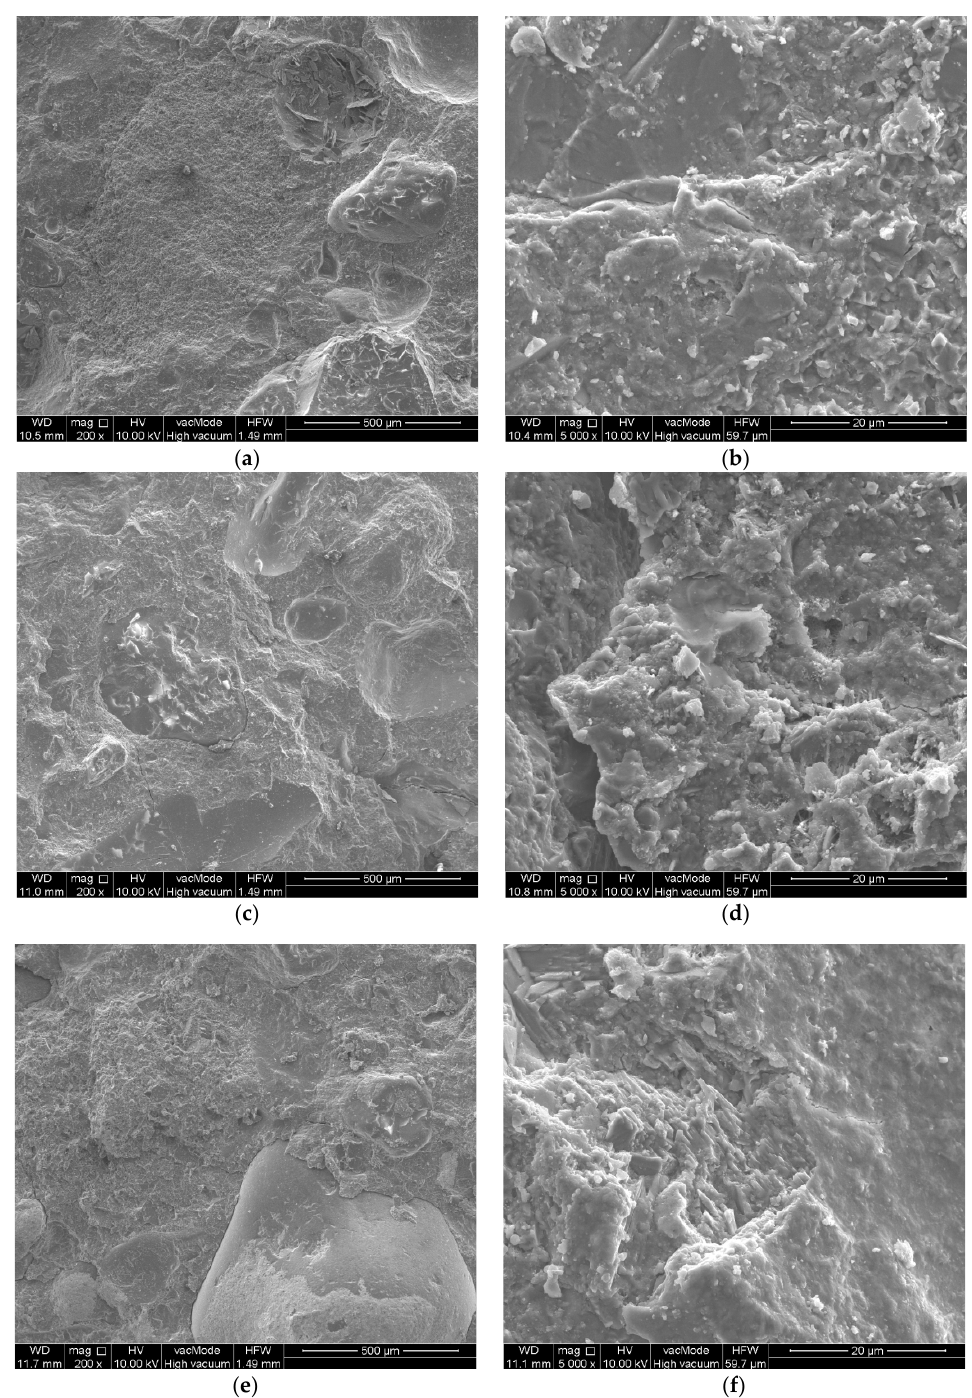
Figure 16. Microstructure of concretes: ( a ) reference—200×, ( b ) reference—5000×, ( c ) concrete with M-NOB—200×, ( d ) concrete with M-NOB—5000×, ( e ) concrete with M-NOzB—200×, ( f ) concrete with M-NOzB—5000×.